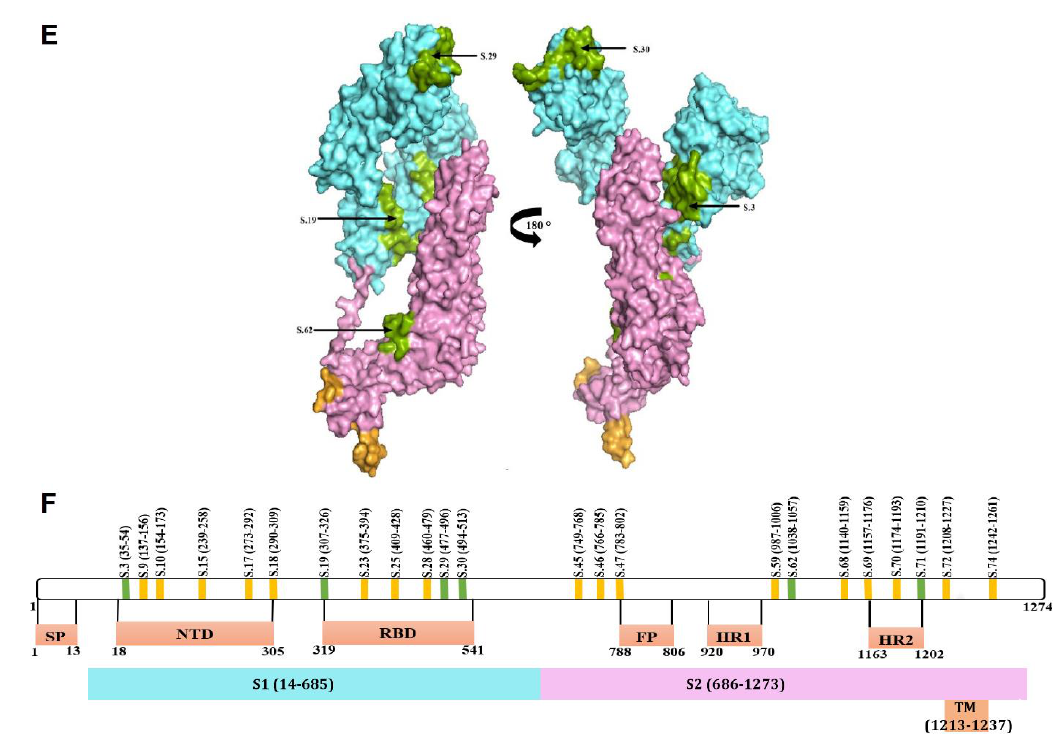
Figure 5. Mapping of peptides recognized by SputnikV immunized and convalescent COVID-19 sera on the three-dimensional SARS-CoV-2 S protein model (PDBid: 6VXX). ( A ) Peptides recognized by both vaccine and convalescent sera (yellow) mapped onto a 3D model of SARS-CoV-2 S protein and ( B ) a linear schematic indicating the location of the peptides in the different domains. ( C ) Peptides recognized only with SputnikV vaccinated sera (red) mapped onto the 3D SARS-CoV-2 S protein model and ( D ) a linear schematic indicating the location of peptides identified in only vaccinated (red) and in both vaccinated and COVID-19 sera (yellow). ( E ) Peptides recognized only with COVID-19 convalescent sera (green) mapped onto the 3D SARS-CoV-2 S protein model and ( F ) a linear schematic indicating the location of peptides identified in only COVID-19 convalescent (green) and both vaccinated and COVID-19 sera (yellow). Blue — S1 domain; Pink — S2 domain; Yellow — TM domain; SP: Signal peptide; NTD: N terminal Domain; RBD: Receptor-binding domain; TM: Transmembrane domain; FP: fusion peptide; HR: heptad repeat.